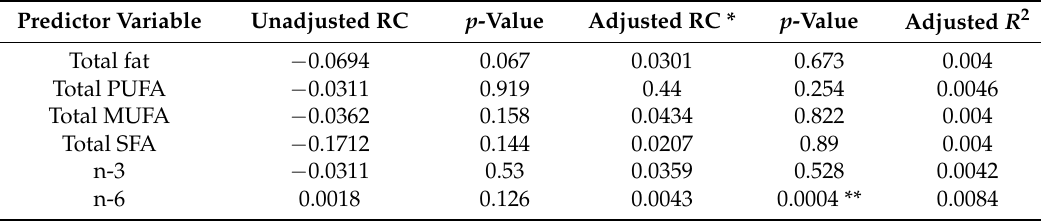
Table 4. Unadjusted and adjusted linear regression results between dietary intake of fatty acids and total ARCS score in the HCS